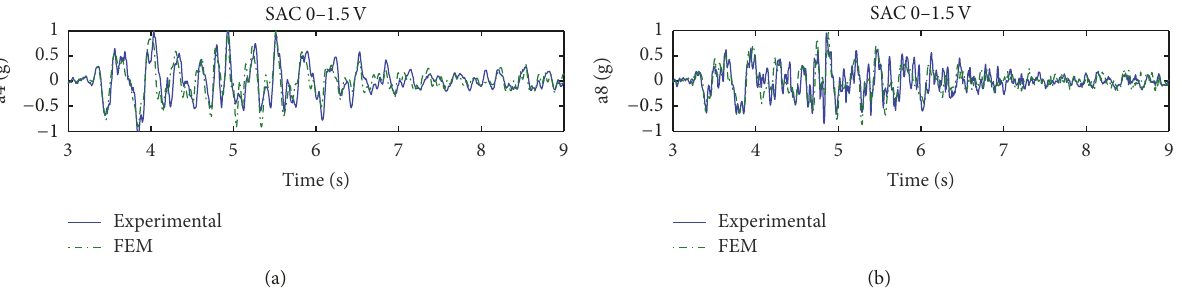
Figure 14: Semiactive connected (SAC) configuration, 0–1.5V, experimental versus FEM 4th floor structure A and 2nd floor structure B acceleration 𝑥 direction. Kobe test PGA 0.5